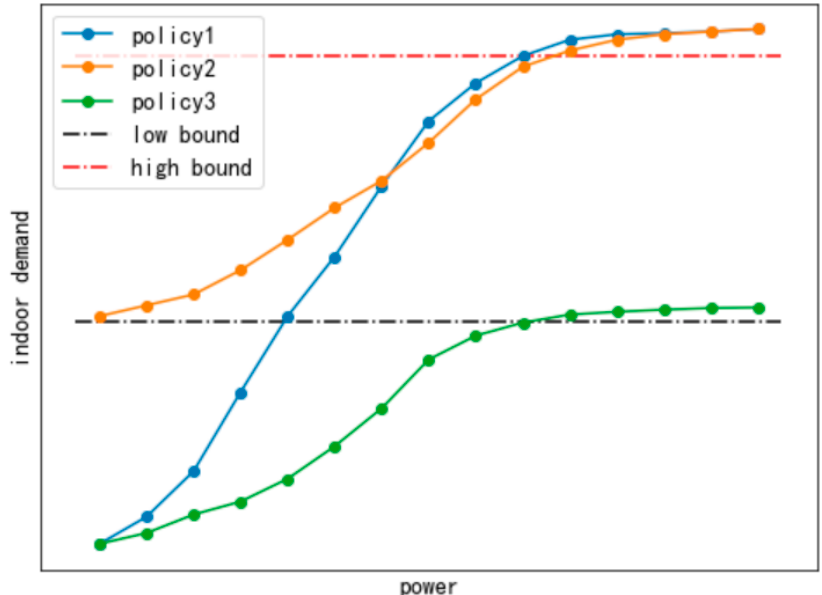
Figure 2. Schematic diagram of the corresponding relationship between the consumed power and the indoor demand satisfaction.